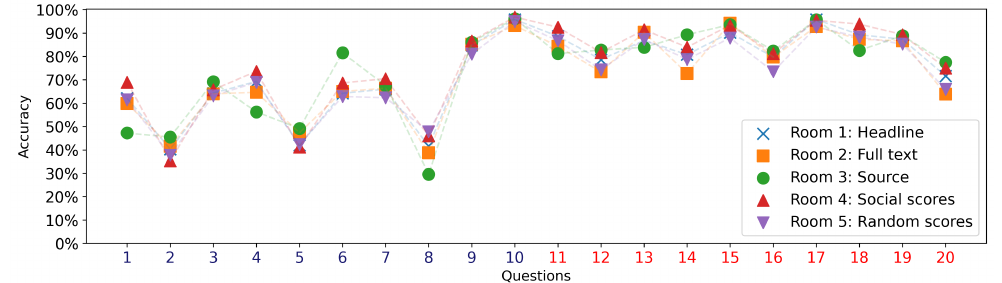
Figure 5. Accuracy for each question, grouped by Room. The source of the news (Room 3) is the feature that can influence users’ judgement the most on the single question, either improving or worsening their scores, especially on questions 1, 4, 5, 8.